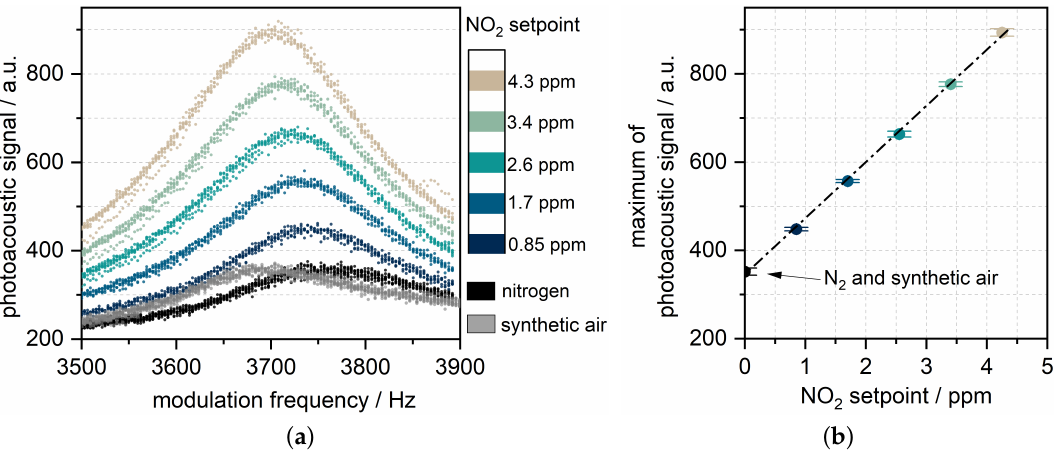
Figure 6. ( a ) Lock-in filtered microphone signal (integration time of 1.14 s) while sweeping the LED modulation frequency over the third harmonic of the resonator at different NO 2 concentrations. A reading is taken every 0.75 s. The resonance frequency shift is due to the dilution of NO 2 in synthetic air. ( b ) Mean value of the three highest points of the sweep, together with their standard deviation ( ± 1 σ ) and the linear